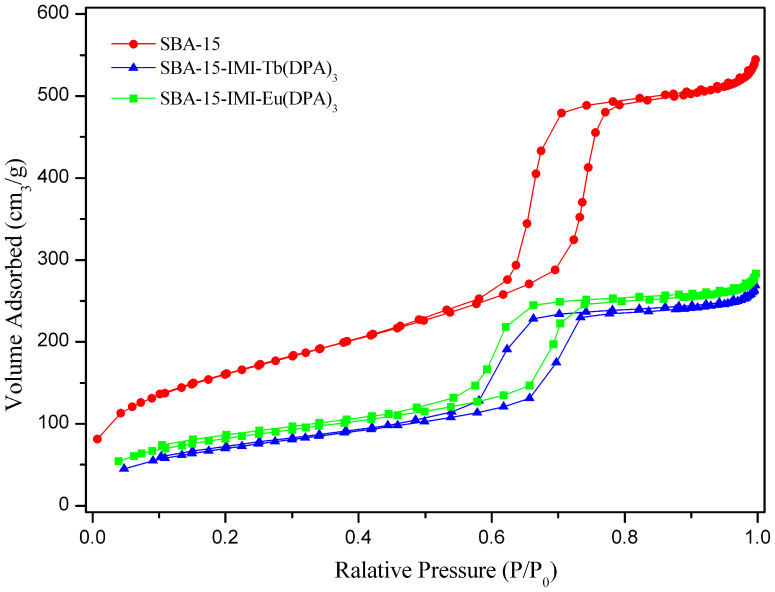
N2 adsorption-desorption isotherms of SBA-15, SBA-15-IMI-Tb(DPA)3, SBA-15-IMI-Eu(DPA)3.